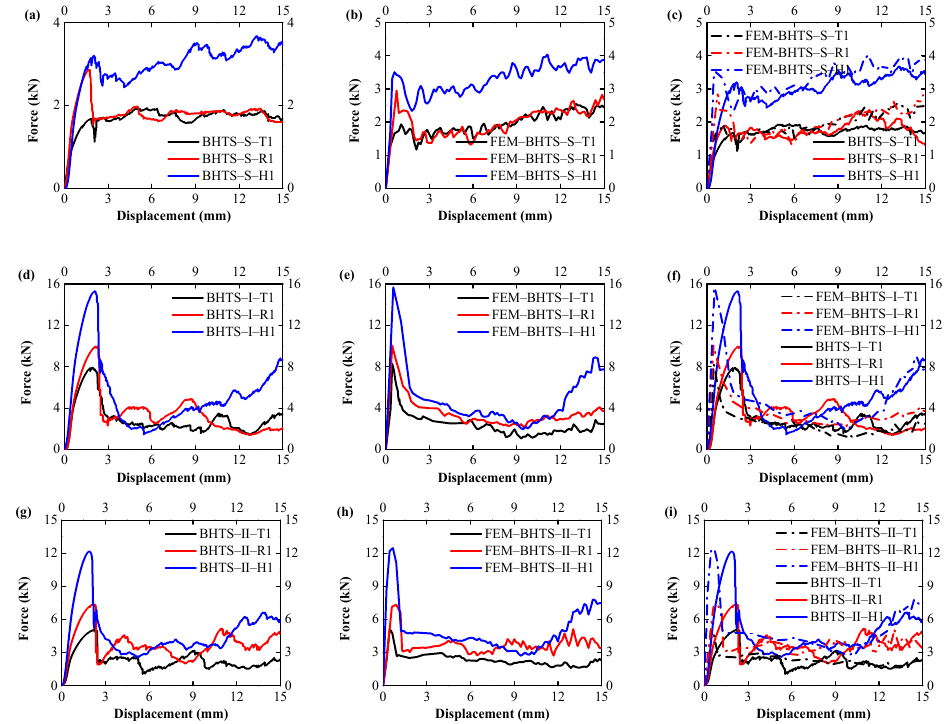
Figure 9. Force ‐ displacement diagram of each structure under quasi ‐ static uniaxial compression Figure 9. Force-displacement diagram of each structure under quasi-static uniaxial loading: ( a – c ) BHTS–S; ( d – f ) BHTS– Ⅰ ; ( g – i ) BHTS– Ⅱ .